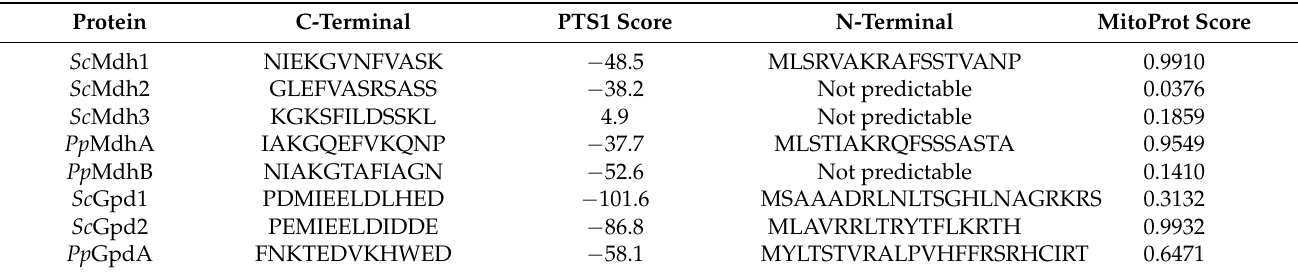
Table 1. In silico analysis of malate and glycerol 3-phosphate dehydrogenases in P. pastoris and S. cerevisiae . PTS1 scores were based on the C-terminal sequences of the dehydrogenases. Scores greater than 0 typically have a predictable PTS1. MitoProt scores were based on the N-terminal predictions for mitochondrial presequences. MitoProtII scores with a probability greater than 0.5 are more likely to be mitochondrial